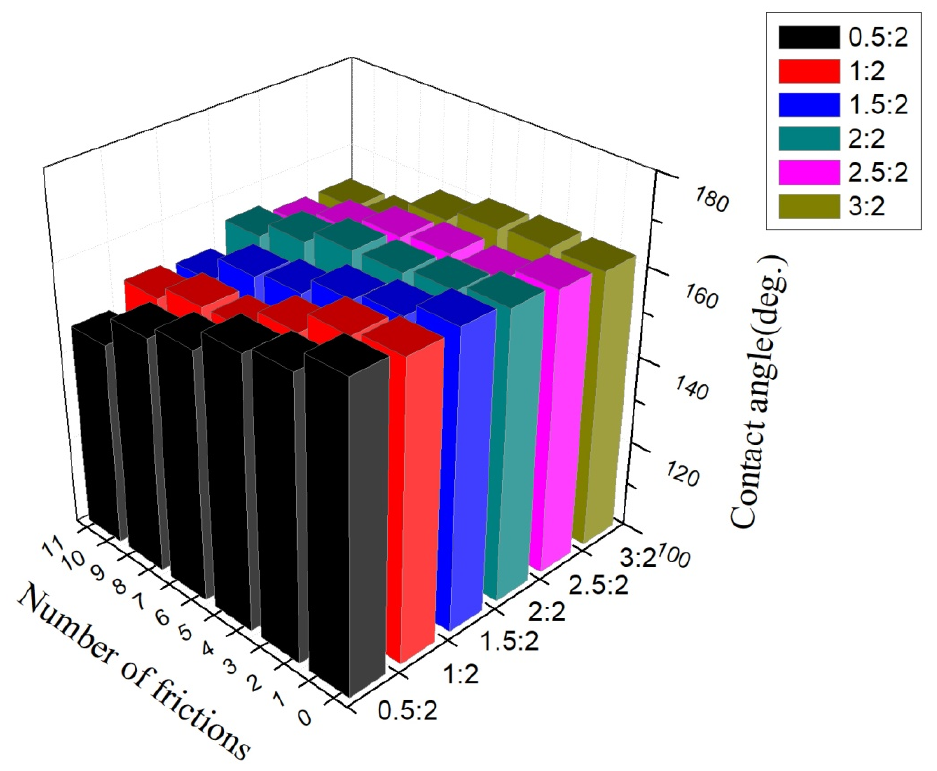
Figure 12. Relationship between the number of frictions and wettability of samples prepared with various mass ratios of resin to ZnO.